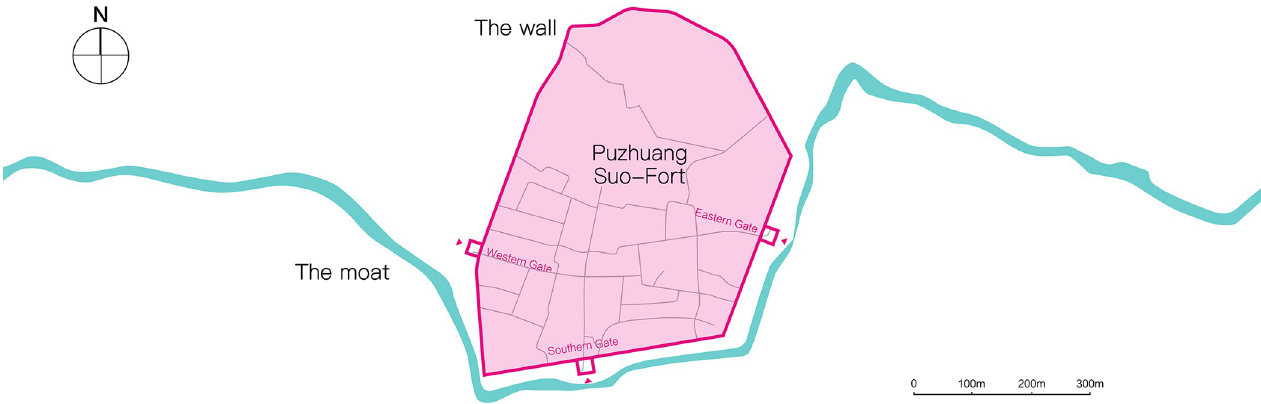
Fig 2. The layout and moat trend of Puzhuang Suo-Fort.